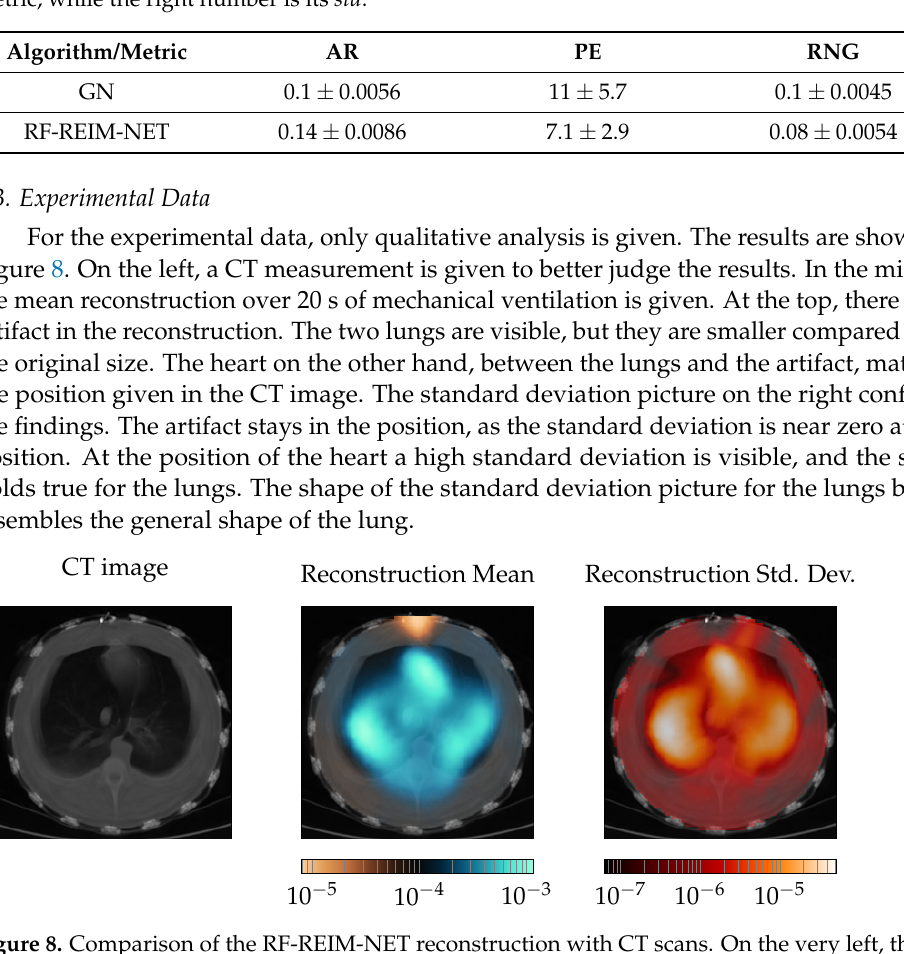
Figure 8. Comparison of the RF-REIM-NET reconstruction with CT scans. On the very left, the CT scan of the pig thorax is given. In the middle, the mean over 20 s of mechanical ventilation is given. On the very right the std is